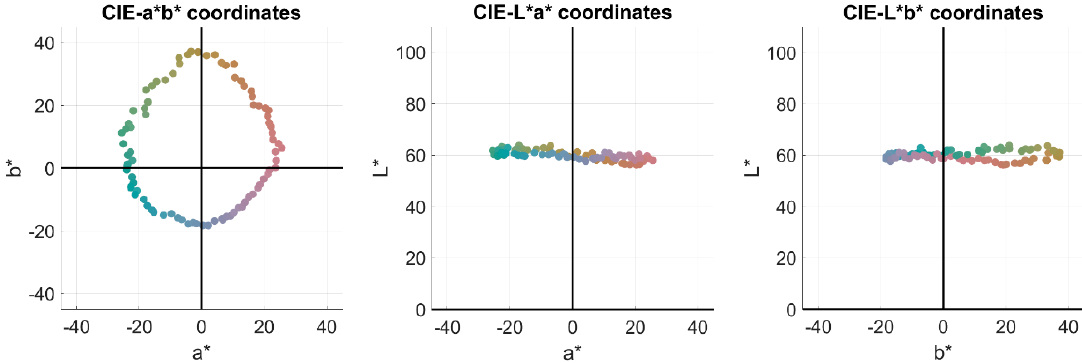
Figure 9. L*, a*, b* data for the FM100 samples under D65, for normal observers in unfiltered